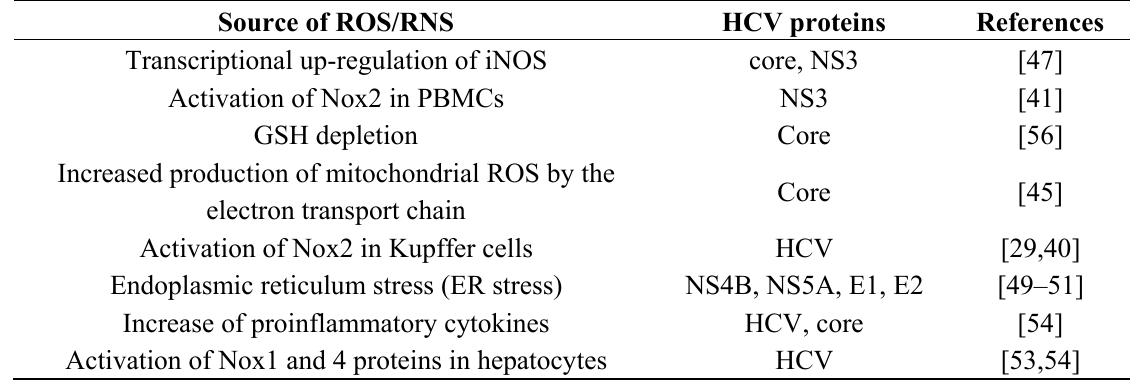
Table 1. Mechanisms of oxidative stress induction by HCV infection and viral proteins